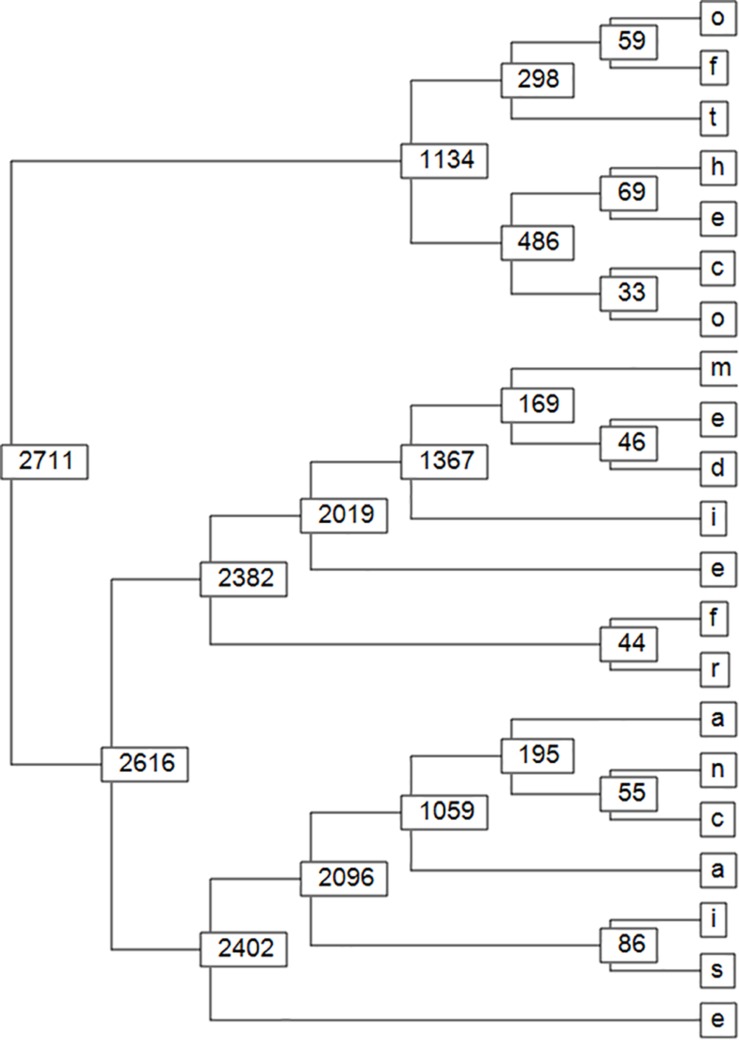
This figure shows the gradual bottom-up detection, level-by-level, of a long recurrent T-pattern of letters: “ofthecomediefrancaise” even if occurring only twice in the short text where word separations (blanks) were removed.